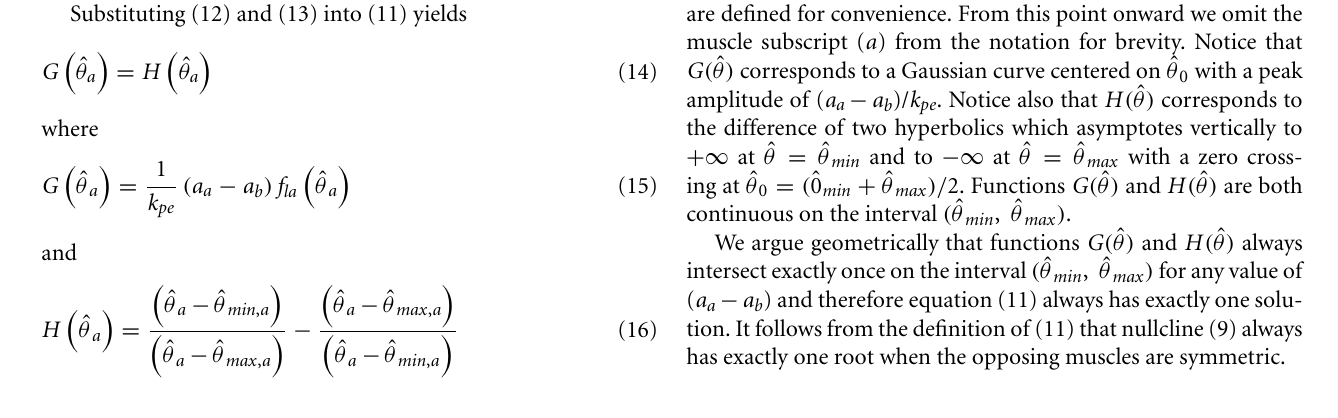
FIGURE 6 | Results of Numerical Experiment 1. (A–C) Show the trajectories of the full biomechanical limb under conditions of medium, strong, and extreme co-contraction in the presence of gravity (denoted by G). Here, medium contraction is close to 20% activation capacity. Strong co-contraction is close to 50% capacity and thus approximates the biological limit of co-contraction. Extreme co-contraction is close to 80% capacity and